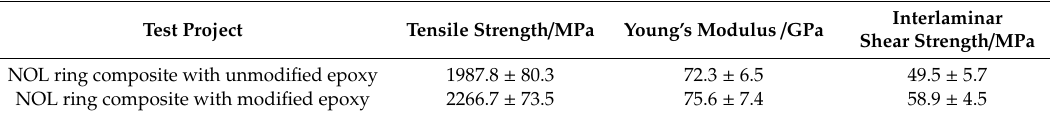
Table 5. Mechanical properties of NOL ring composite.